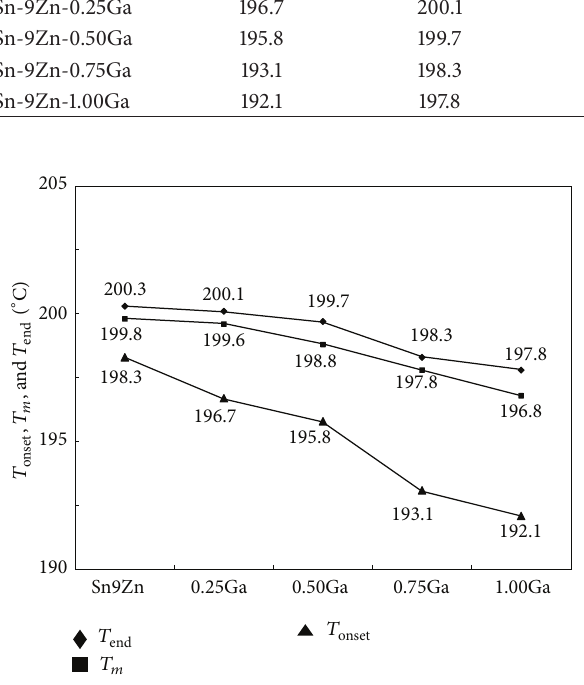
Figure 2: The solidus temperature ( 𝑇 ( 𝑇 𝑚 ), and liquidus temperature ( 𝑇